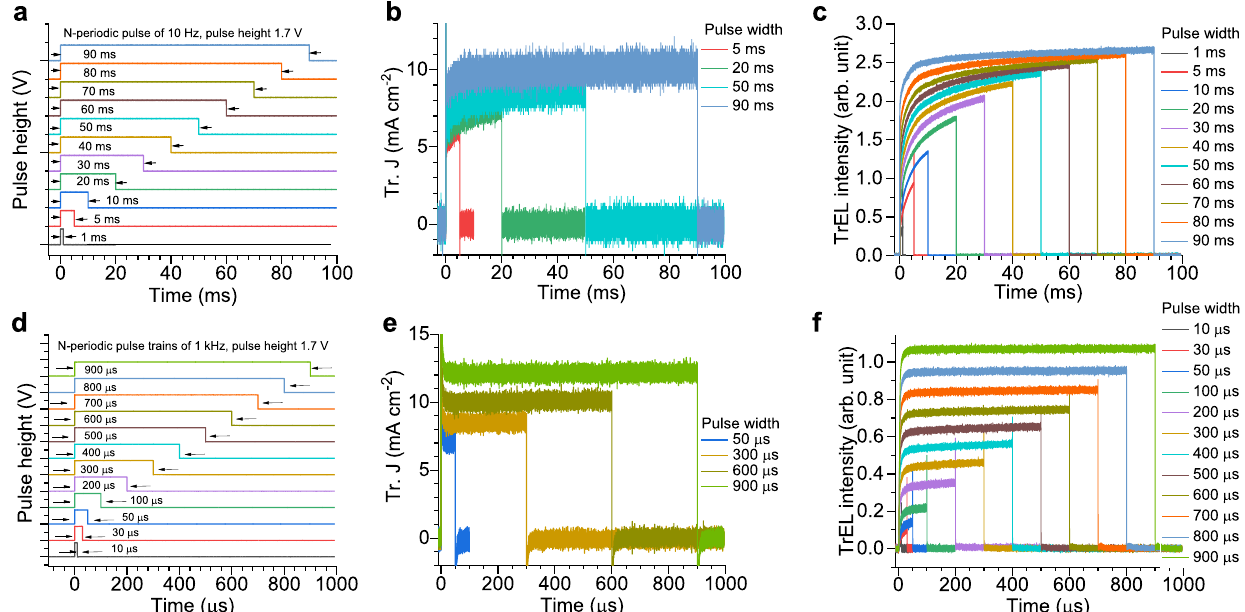
Fig. 2 Pulse width dependent transient electroluminescence (TrEL) characterisations of the near-infrared (NIR) perovskite light-emitting diode (PeLED) at 10 Hz and 1 kHz. a Schematic diagram of N- periodic pulse trains of 10 Hz frequency, wherein black arrows show voltage pulse widths (from 1 ms to 90 ms), which are used to excite the PeLED. b Transient current density (Tr. J) and c TrEL intensity as a function of the pulse widths, which are shown in Fig. 2a. d Schematic diagram of N- periodic pulse trains of 1 kHz frequency, wherein black arrows show voltage pulse widths (from 10 μ s to 900 µ s), which are used to excite the PeLED. e Tr. J and f TrEL intensity as a function of the pulse widths, which are shown in Fig. 2d. For the fi gure clarity, here, we show Tr. J only for selected pulse widths; for the other pulse widths at 10 Hz and 1 kHz, Tr. J curves are shown in Supplementary Figs. 3b and 8b, respectively. TrEL and Tr. J data have also been measured for the other pulse widths in the range of 10 Hz to 20 kHz (Supplementary Figs. 3 to 11). Both Tr. J and TrEL intensity increase with increasing pulse widths for all the frequencies we investigated.